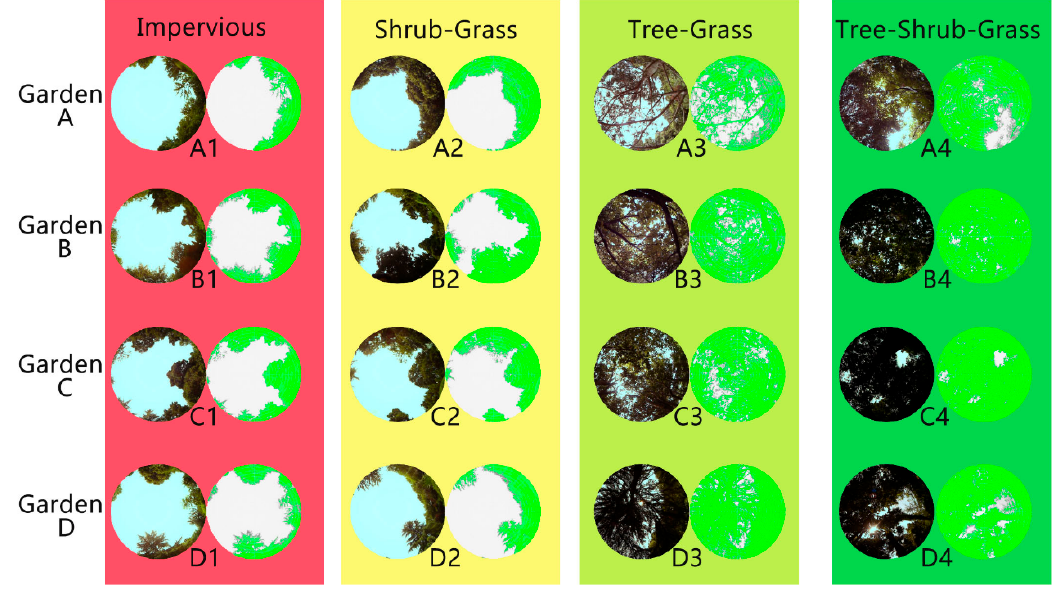
Figure 3. Fisheye images and leaf area images of each point in four gardens measured by the plant canopy imager (four coverage types).